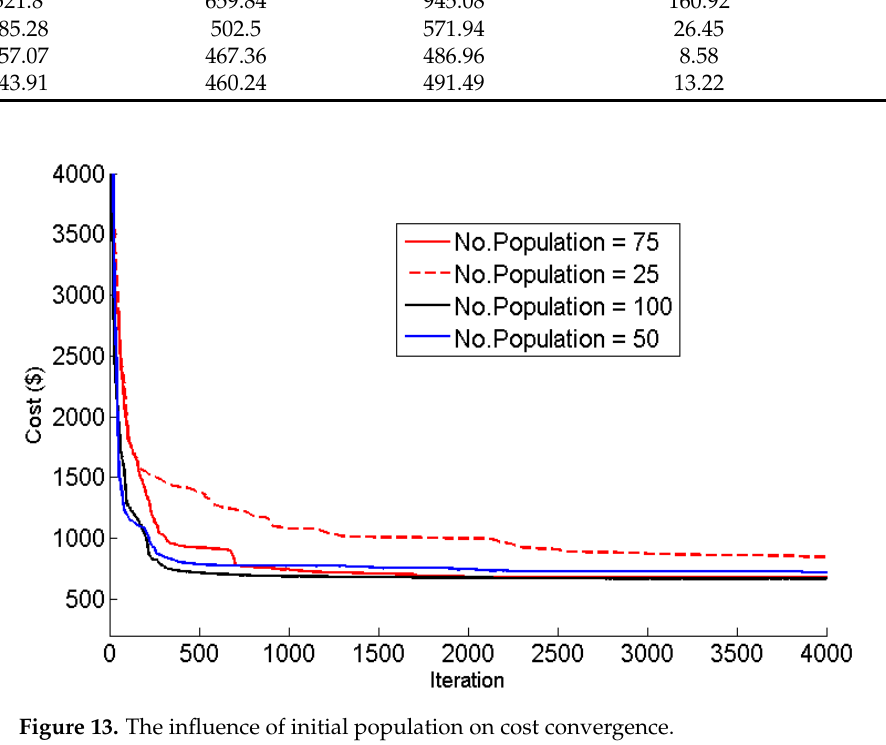
Figure 15. Impact of population changes on the Pareto Front (cost and emission based). Figure 16 compares normal loading and survivability of loads during different hours a day. As can be seen from Figure 16, a significant proportion of loads in the MG has been supplied, which in turn shows the effectiveness of proposed method to enhance power system resilience after long-time outage.